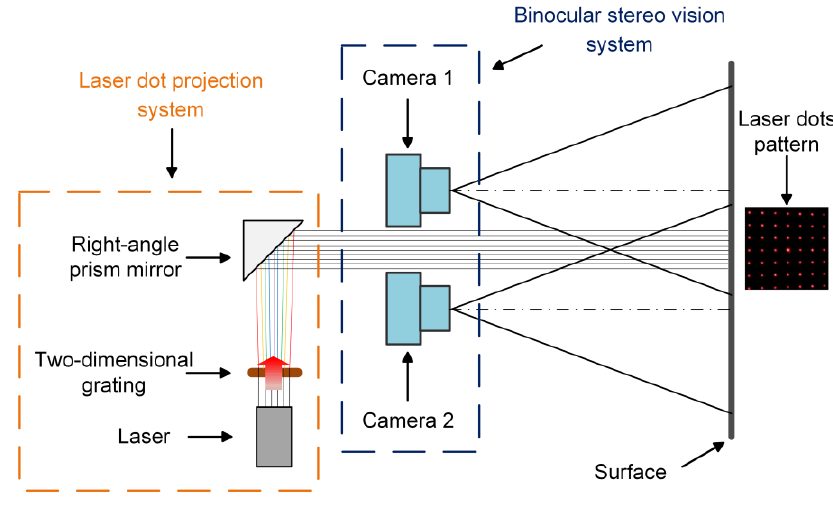
Figure 3. The schematic of the 3D scanning system.